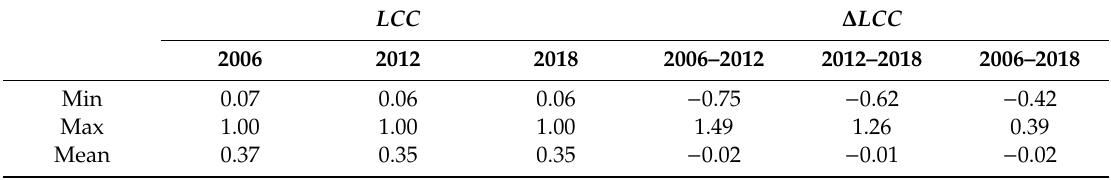
Table 4. Statistical parameters of the LCC indicator and the increase in indicator values.